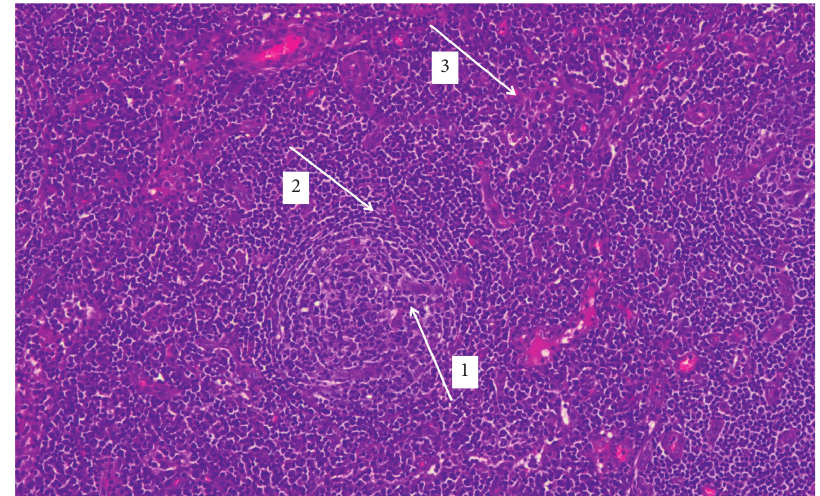
Figure 1: Hematoxylin and eosin stain, original magnification × 10. Germinal centers traversed by penetrating vessels (arrow 1) and thickened mantle zones with lymphocytes arranged in layers with onion skin appearance (arrow 2). In the interfollicular areas, there is extensive vascular proliferation with perivascular hyalinization (arrow 3).